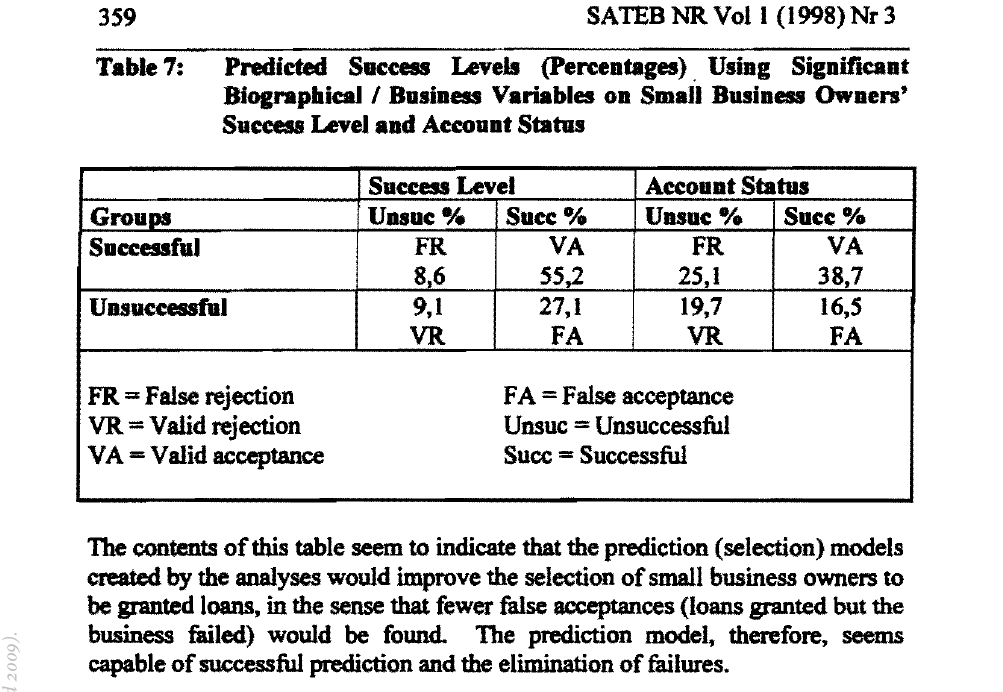
Table 7: Predicted Success Levels (percentages). Using Significant Biographical I Business Variables on Small Business